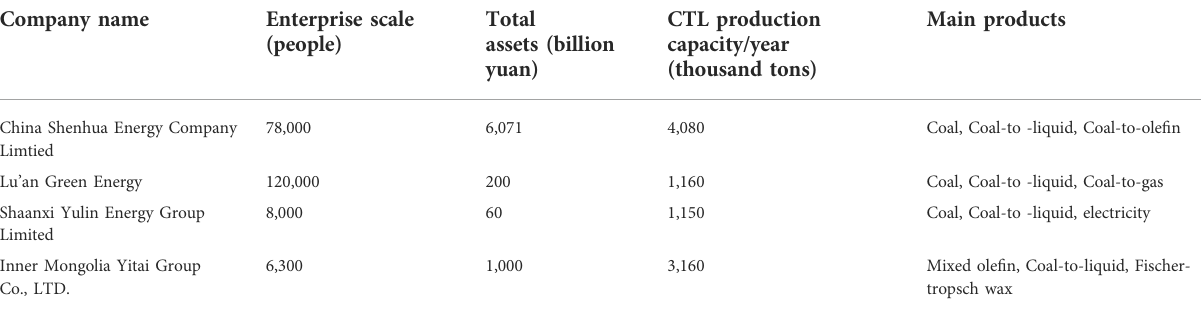
TABLE 1 Basic information of China ’ s listed CTL enterprises in 2022.